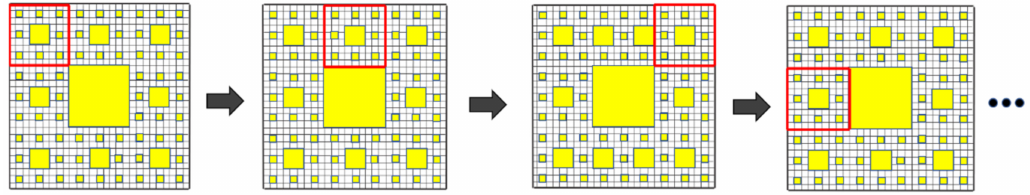
Figure 2. Box-counting method dimension operation